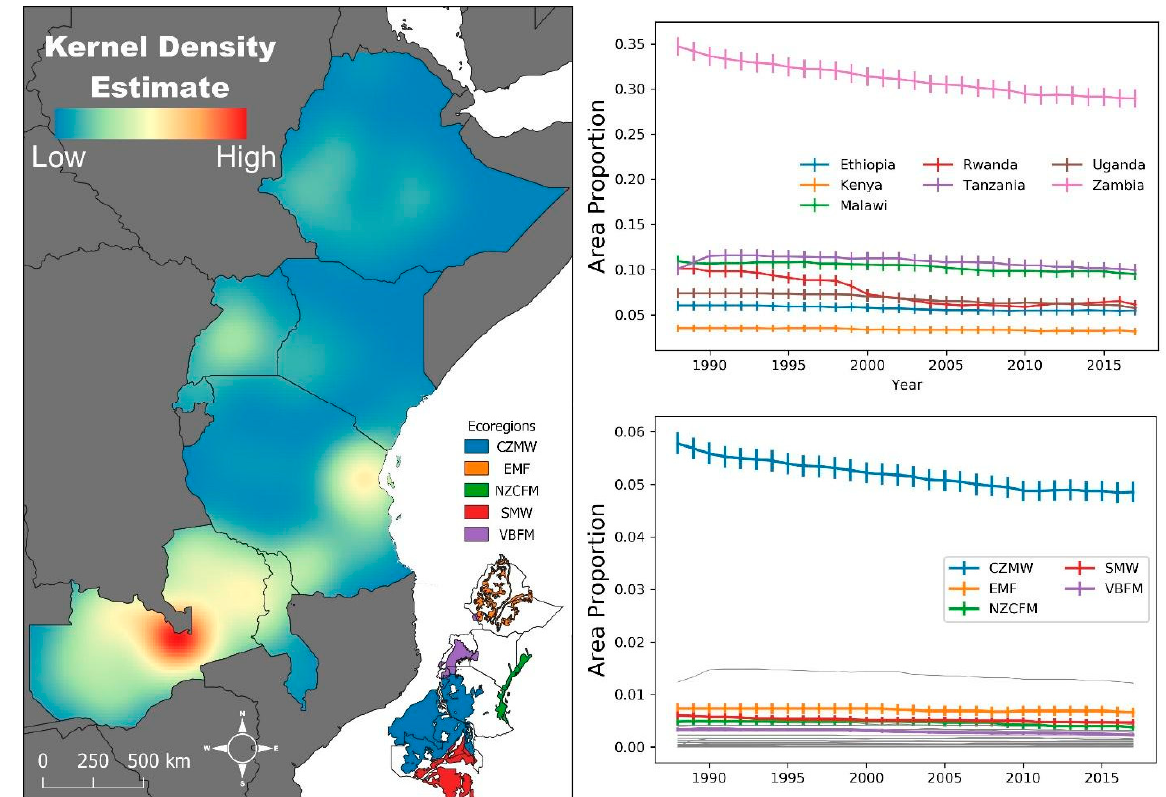
Figure 8. Deforestation in Open Forests in East Africa. Left: Kernel Density hotspot analysis of deforestation in Open Forests. Top, proportional change of Open Forest in seven countries with 95% confidence intervals expressed as vertical lines. Bottom, Proportional change of Open Forest in ecoregions in which the five ecoregions with the greatest change are colored (CZMW, Central Zambezian Miombo Woodlands, VBFM, Victoria Basin Forest-Savanna Mosaic, EMF, Ethiopian montane forests, SMW, Southern miombo woodlands, NZCFM, Northern Zanzibar-Inhambane coastal forest mosaic). The grey lines represent the other ecoregions.